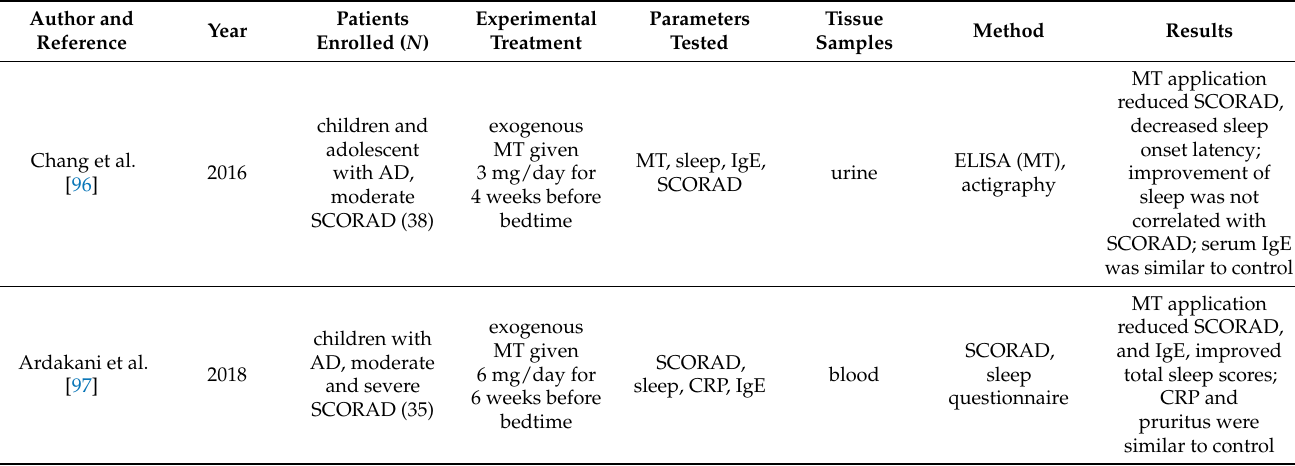
Table 2. Summary of findings from the experimental human